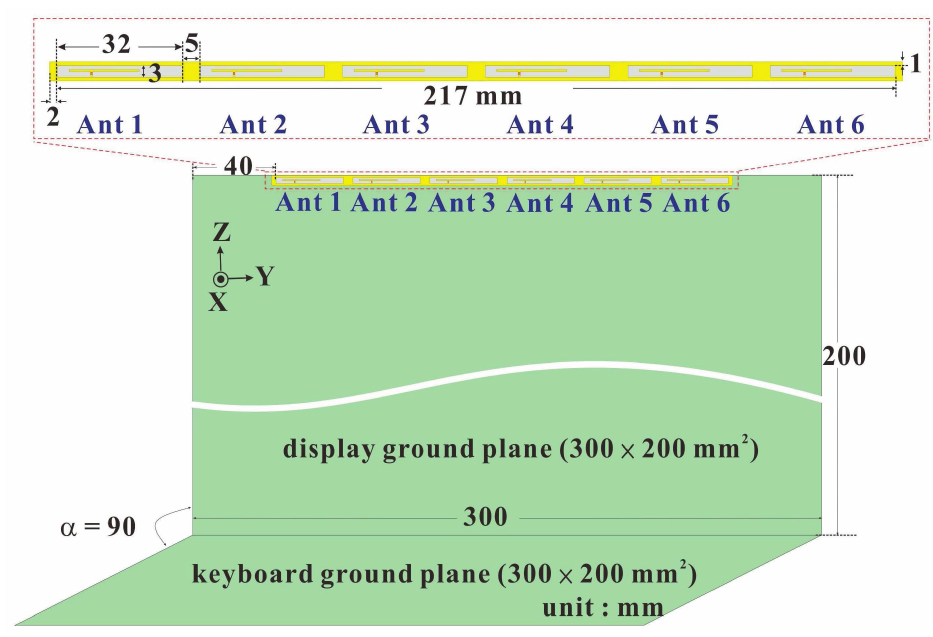
Figure 1. Overall design of the six 5G MIMO antennas.